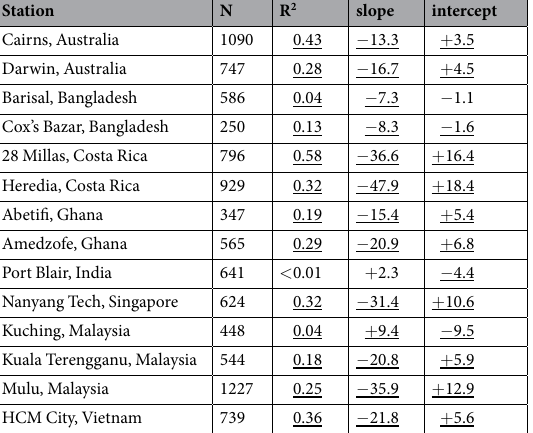
Table 3. Observations (N), correlation coefficients (R 2 ) and linear coefficients of relationship between 10-day Statistically significant (p < 0.05) values are